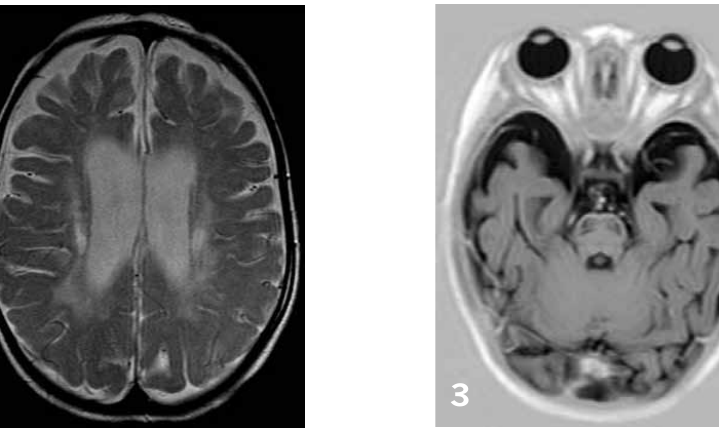
Fig. 3 is an axial inversion recovery